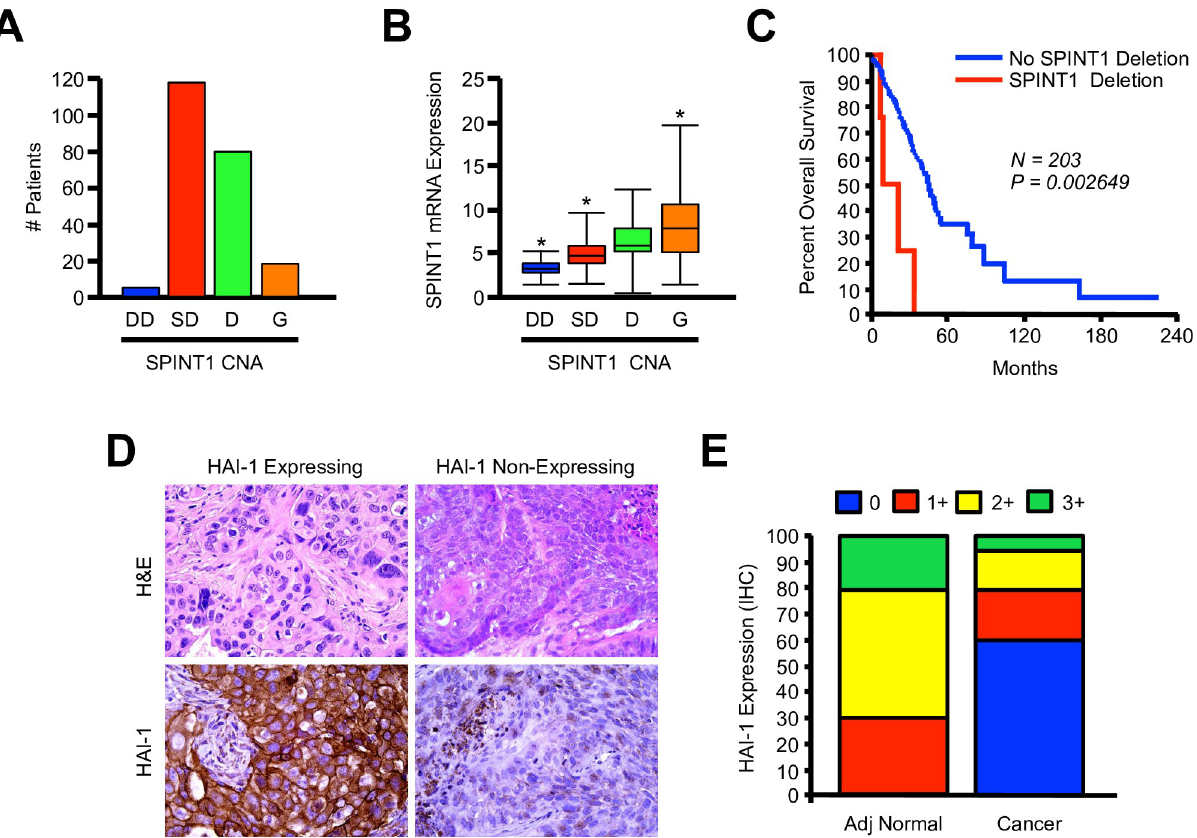
Fig 1. HAI-1 is downregulated in NSCLC and is associated with poor clinical outcomes. (A) Patient genomic profiles from the TCGA dataset were evaluated for copy number alteration (CNA) to HAI-1 ( SPINT1 ), and arranged as either having deep deletion (DD), shallow deletion (SD), diploid (D), or gain of copy number (G). (B) Relationship between CNA and mRNA expression of SPINT1 . (C) Kaplan-Meier curve showing overall survival for SPINT1 -intact patients compared to those with deep deletion of SPINT1 . (D) NSCLC patient tissues were stained either with H&E or by immunohistochemistry for HAI-1. Representative images are shown for HAI-1 expressing and non-expressing tissue sections. (E) HAI-1 expression was quantified as described, and compared between NSCLC and adjacent non-malignant